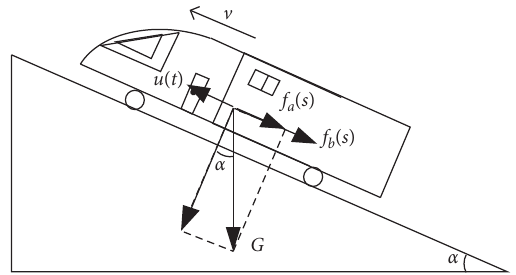
Figure 1: Diagram of slope additional